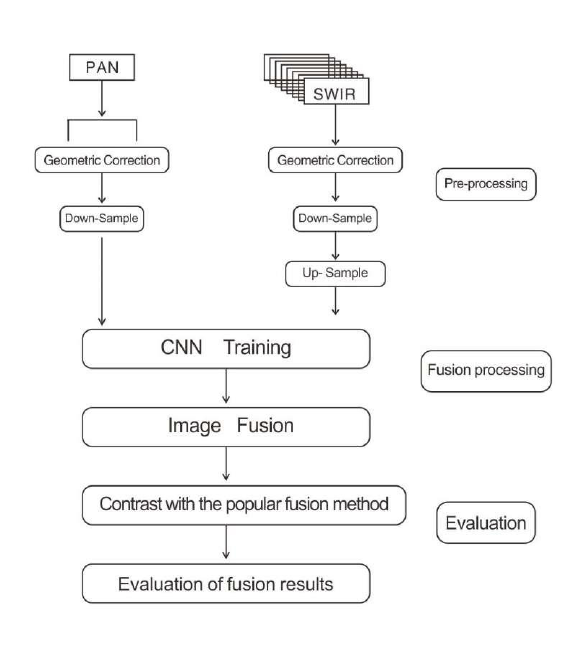
Figure 3. The processing flowchart of the proposed pan-sharpening